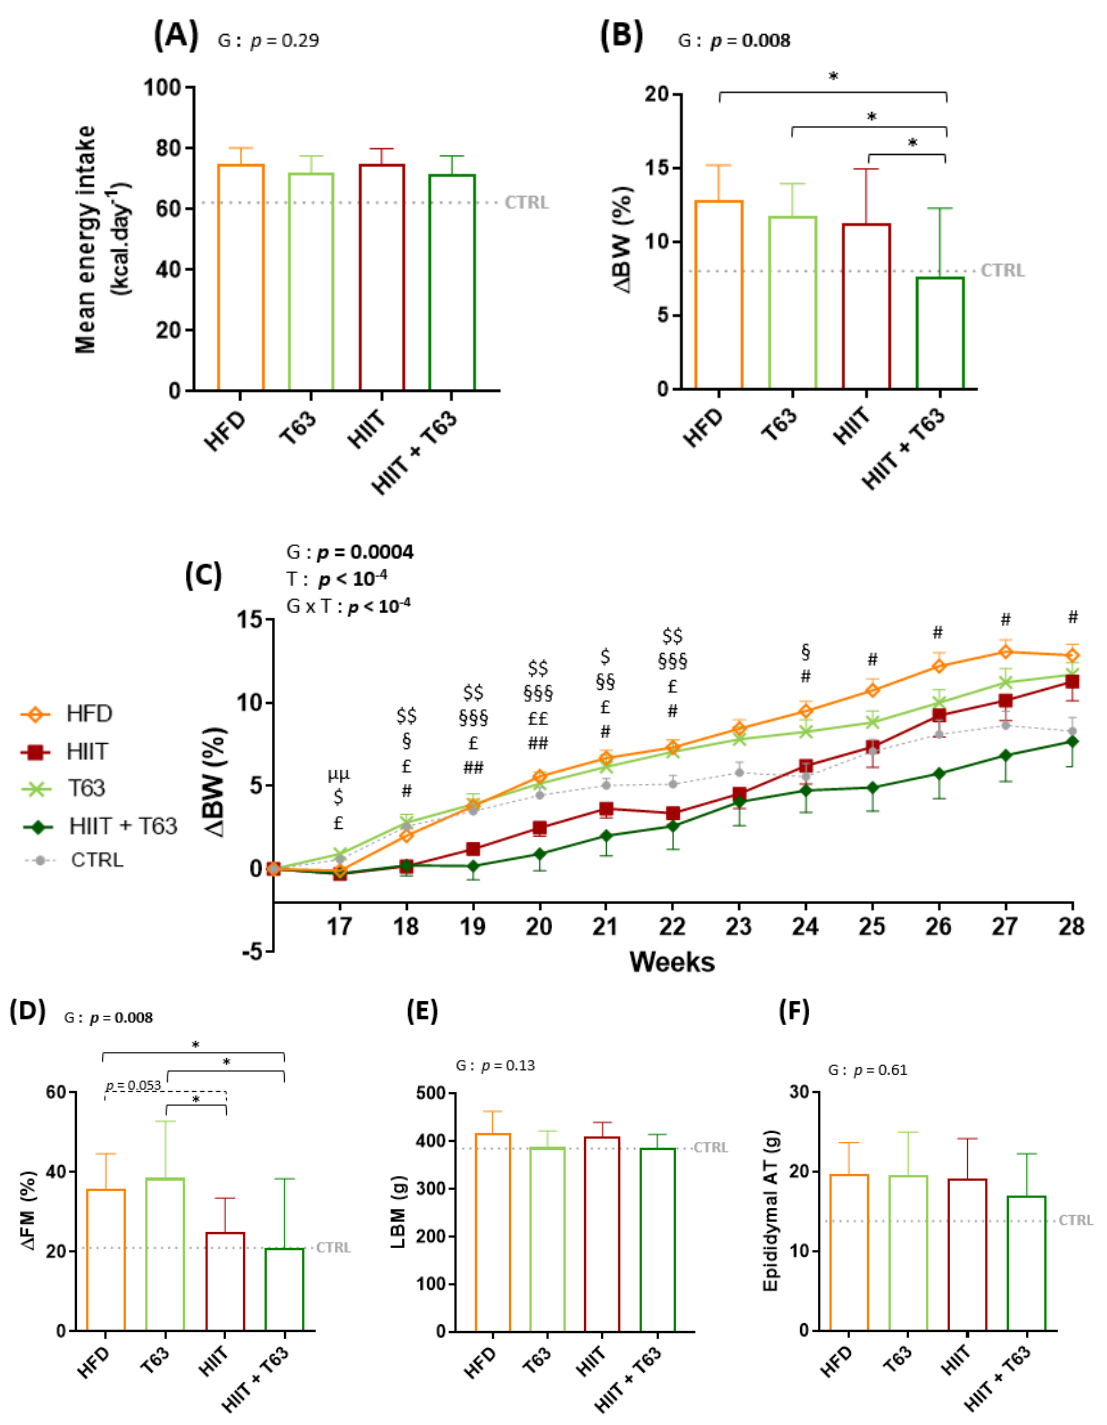
Figure 3. Mean energy intake in the four groups ( A ). Changes in body weight (ΔBW) ( B , C ), fat mass (ΔFM) ( D ), lean body mass (LBM) ( E ), and epididymal adipose tissue (AT) ( F ) at the end of the 12-week intervention. * p < 0.05, μ p < 0.05: HFD vs. T63, $ p < 0.05, $$ p < 0.005: HIIT vs. T63, § p < 0.05, §§ p < 0.005, §§§ p < 0.0005: HIIT vs. HFD, £ p < 0.05, ££ p < 0.005: HIIT + T63 vs. T63, # p < 0.05, ## p < 0.005: HIIT + T63 vs. HFD. ΔBW = ((Week 28 BW − Week 16 BW)/Week 16 BW) × 100; ΔFM = ((Week 28 FM − Week 16 FM)/Week 16 FM) × 100, G: group effect, T: time effect, G × T: group × time effect.